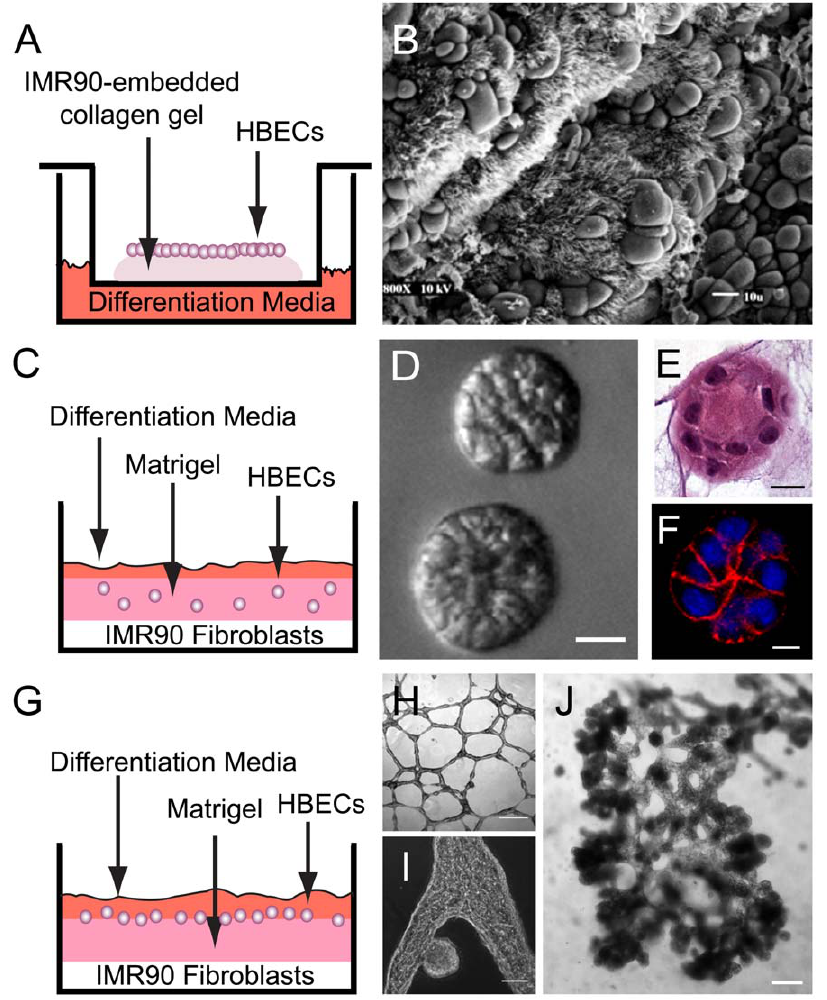
Figure 1. HBEC3 KTs Respond Distinctly to Cues from Microenvironment. HBEC3 KTs were seeded into three different 3D culture models (Figs A, C, and G) and overall response monitored. Culture of the HBEC3 KT cells atop of an IMR-90-embedded collagen type I matrix (Fig A) results in the differentiation into ciliated and/or goblet cells. Scanning electron micrograph (EM) of apical surface of HBEC3 KTs after 3 weeks at an air-liquid interface (Fig B; scale bar 10 m m). Embedding single HBEC3 KT cells within Matrigel TM in the presense of IMR90 fibroblasts (Fig C) results in the formation of organized cyst-like structures comprised of cuboidal cells. Phase contrast image, H&E section, and immunofluorescence staining for E- cadherin (red) in HBEC3 KT cyst-like structures after 5 days of culture (Figs D, E, and F respectively) (scale bar 20 m m; DAPI (blue)). Alternatively, seeding of HBEC3 KT cells on top of Matrigel TM in the presence of IMR90 fibroblasts (Fig G) results in the aggregation into tubular structures from which bud structures emerge over time. Phase contrast images of HBEC3 KTs 24 hours after plating on Matrigel TM (Fig H; scale bar 100 m m), of budding structure (Fig I; scale bar 20 m m), and after 5 days in culture (Fig J; scale bar 200 m m). Results are representative of . 20 independent